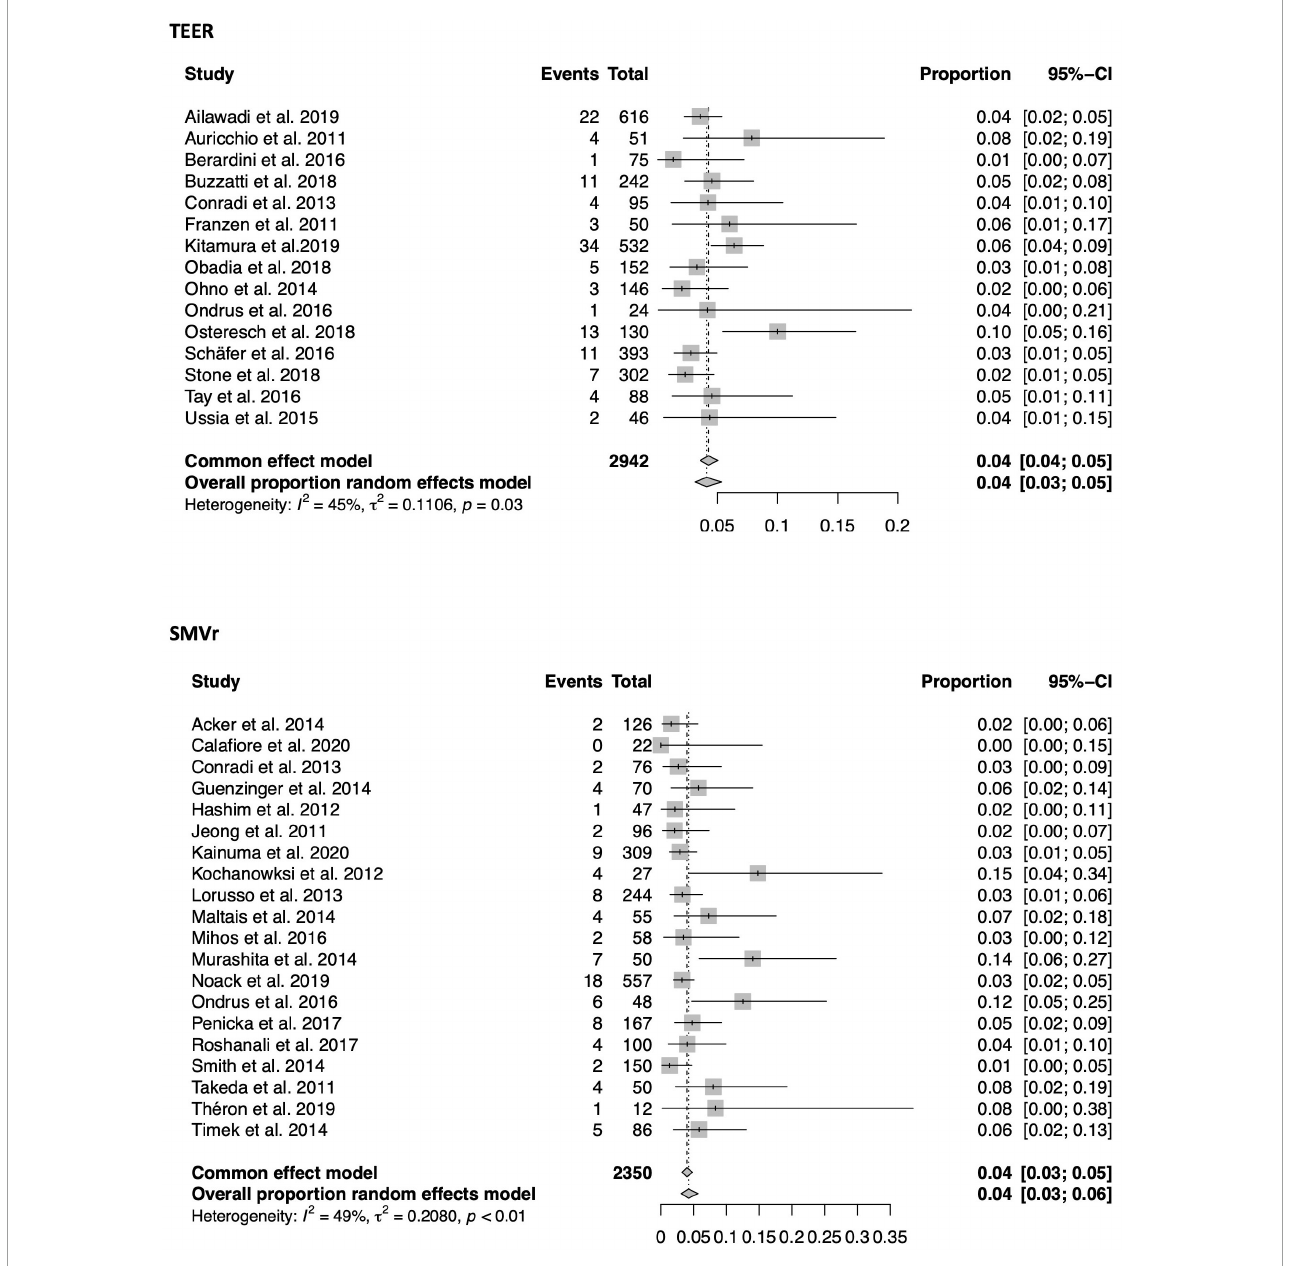
FIGURE4 Forrest plots of the comparison between TEER and SMVr for 30-day mortality. TEER, transcatheter edge-to-edge repair; SMVr, surgical mitral valve repair.